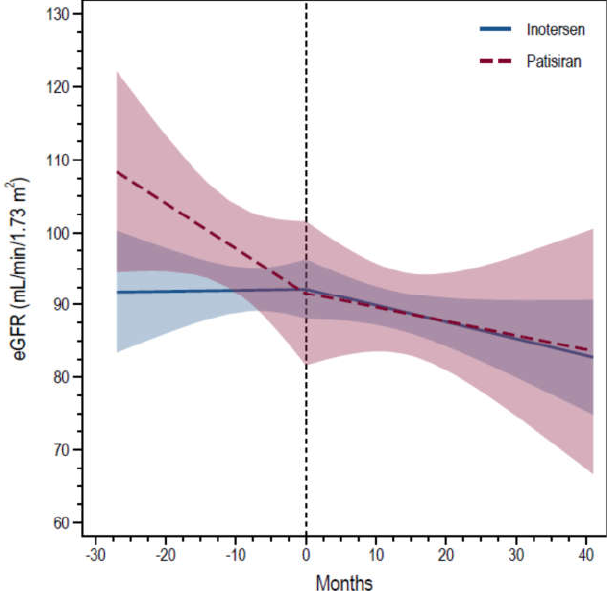
Figure 1. The graph reports the estimated change in eGFR over time before and after treatment initiation with inotersen (solid blue line) and patisiran (dotted red line), with shades representing 95% confidence intervals. The vertical dotted line represents treatment initiation. No significant difference either between the two groups of treatment or within-group before and after therapy (all p -values > 0.05) was observed. Table 1. Demographic and clinical characteristics of the two treatment groups. Categorical varia- bles are expressed as count and percentage (%). Numerical variables are expressed as mean ± standard deviation (SD) or median and interquartile range (IQR). N represents the number of en- rolled subjects in each group.